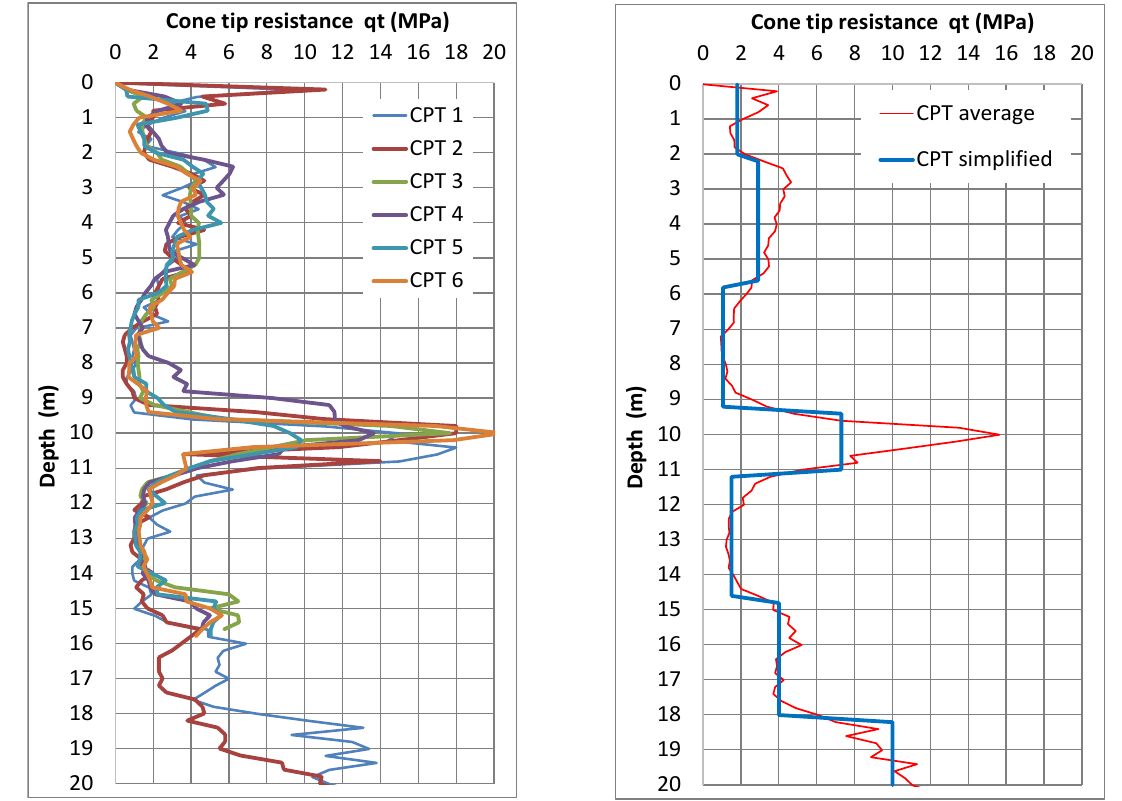
Figure 5. All penetration tests next to the towers ( left ) and average of all tests ( right ) [5]. After that, clays reappear, ending above a layer of compacted sand at a depth of 18 to 20 m. According to historic data, this location in the past was bordered by swampy troughs and canals, which is indicated by the presence of muddy and marshy impurities in the upper parts of the terrain. According to limited piezometric measurements (Figure 6), the groundwater depth is at 3.2 to 4.2 m from the ground level around the Cathedral (112.6 m MASL). Based on the excavations, the depth of the foundation of the northern tower is ap- proximately 2.5 m, while at the southern tower, it is at approximately 3.0 m. Testing of the bricks from the foundation wall showed that their compressive strength ranges from 1.3 to 2.0 MPa. The bottom parts, the footings, of the tower foundations have a surface of approximately 8 × 8 m, and a thickness of 2.0 m, and were made from an uneven mixture of lime concrete with sand and irregular pieces of larger and smaller bricks and sandstone rocks, Figure